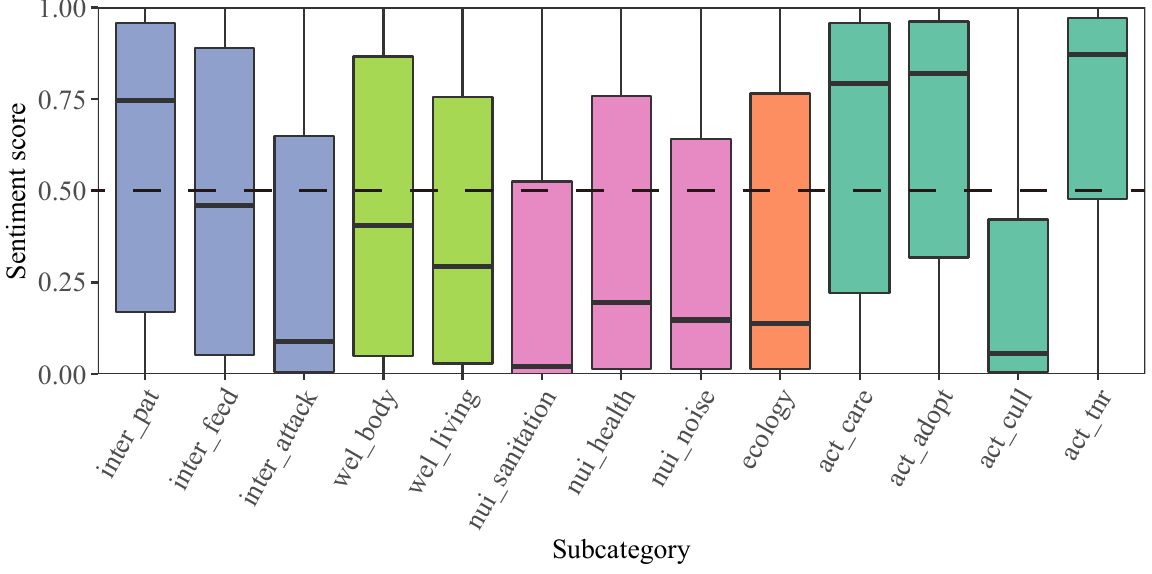
Figure 4. The sentiment scores of thirteen subtopics.